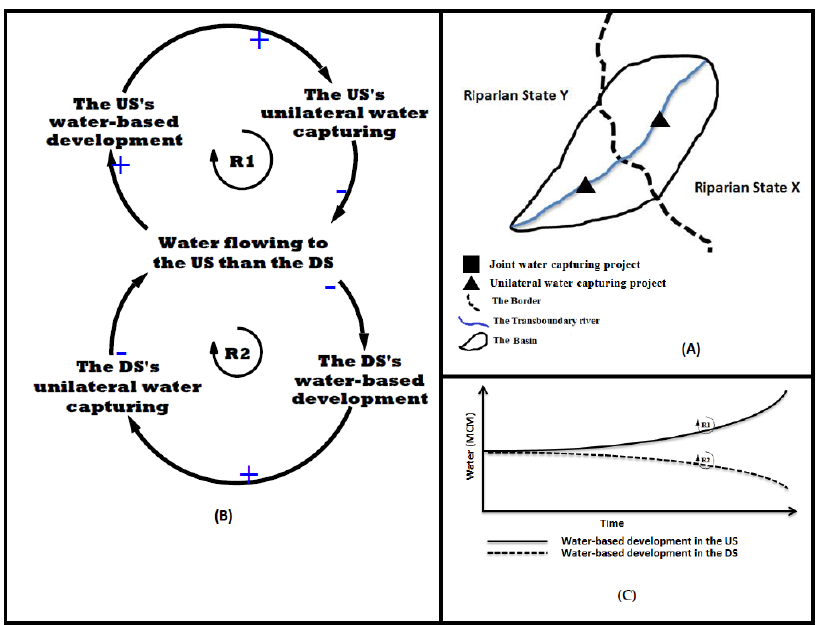
Figure 1. ( A ) The schematic of the physical environment that can embrace HSA1 (real cases in Appendix, Table A1). ( B ) The “bully and the bullied” archetype. ( C ) The schematic of HSA1 behavior with its responsible loops.